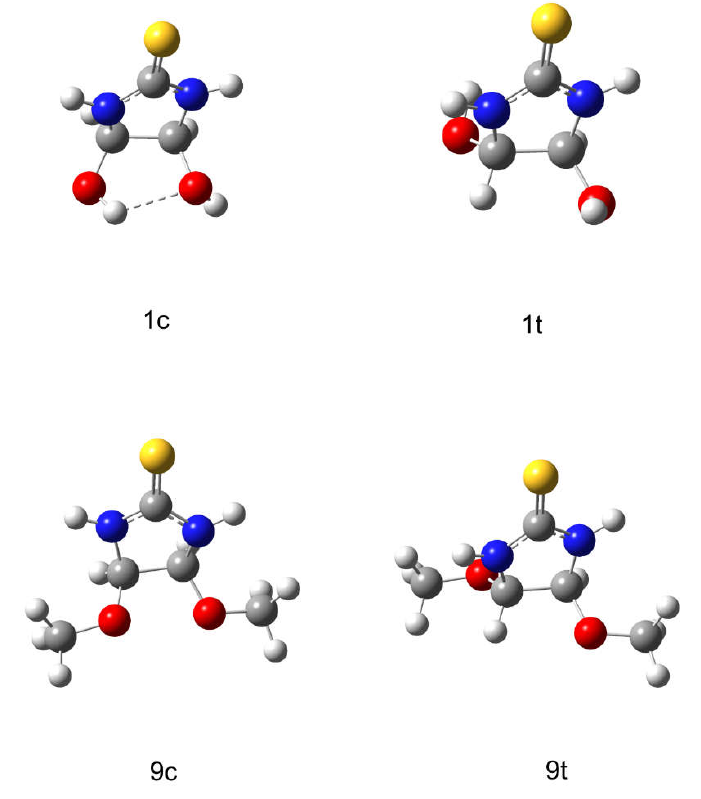
Figure 7. The cis and trans structures of DHIT 1 and its dimethyl ether 9.